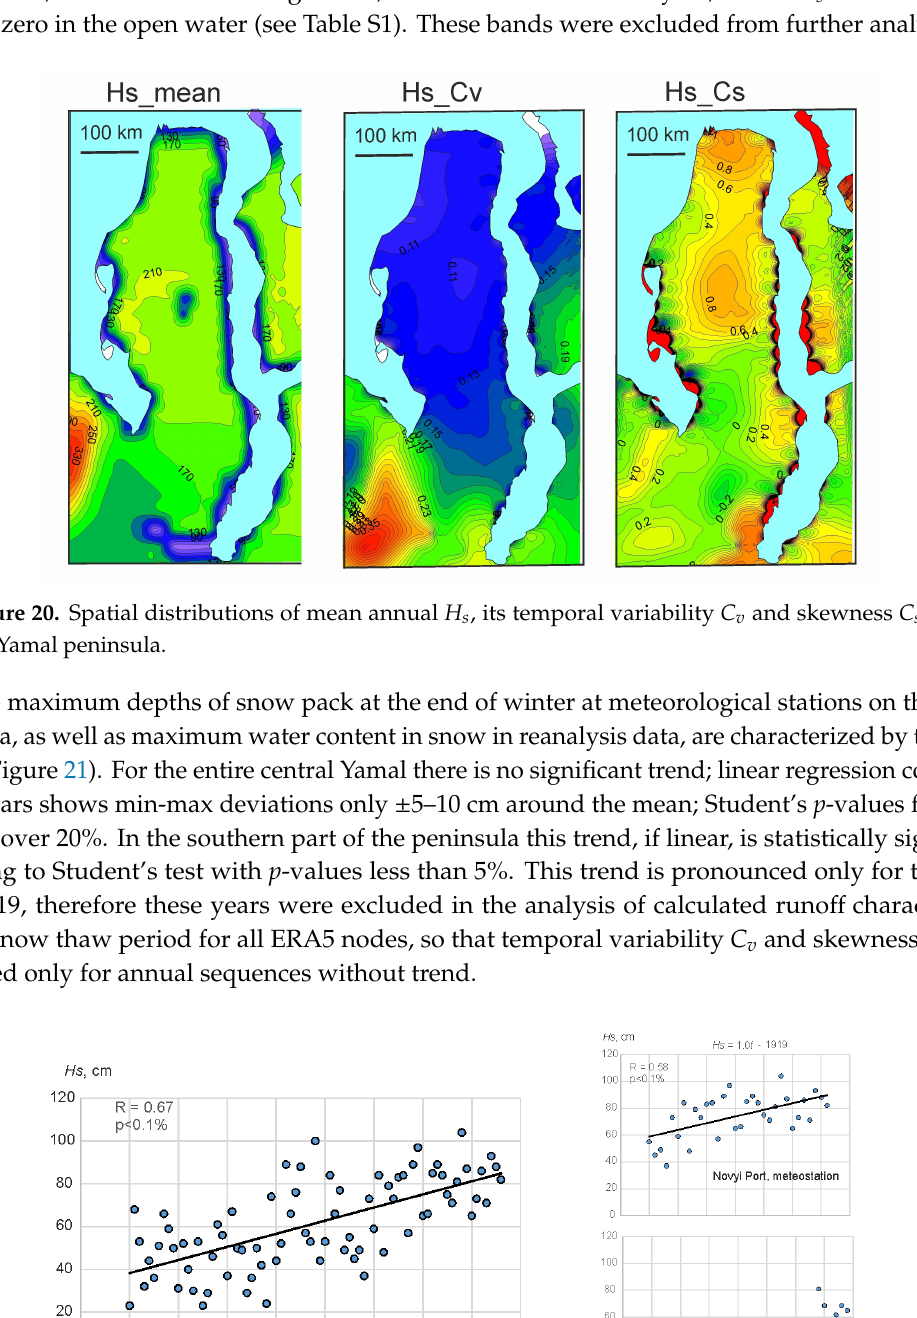
Figure 21. Temporal changes of maximum snow pack depth at the end of the winter at the Novy Port station for two periods–1940–2016 and 1985–2016, and the same for the second mentioned interval from ERA5 reanalysis at the nearest grid node.